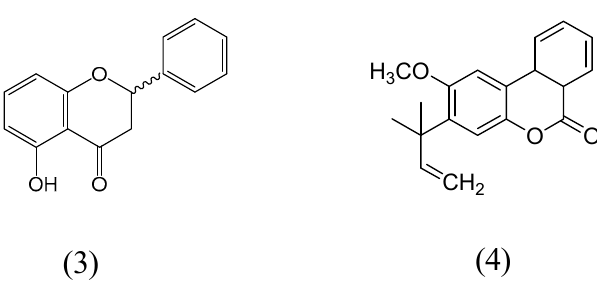
Figure 13. Structures of 5-hydroxyflavanone ( 3 ) and 2-methoxy-3-(1-dimethylallyl)-6a,10a- dihydrobenzo(1,2-c)chroman-6-one ( 4 ).